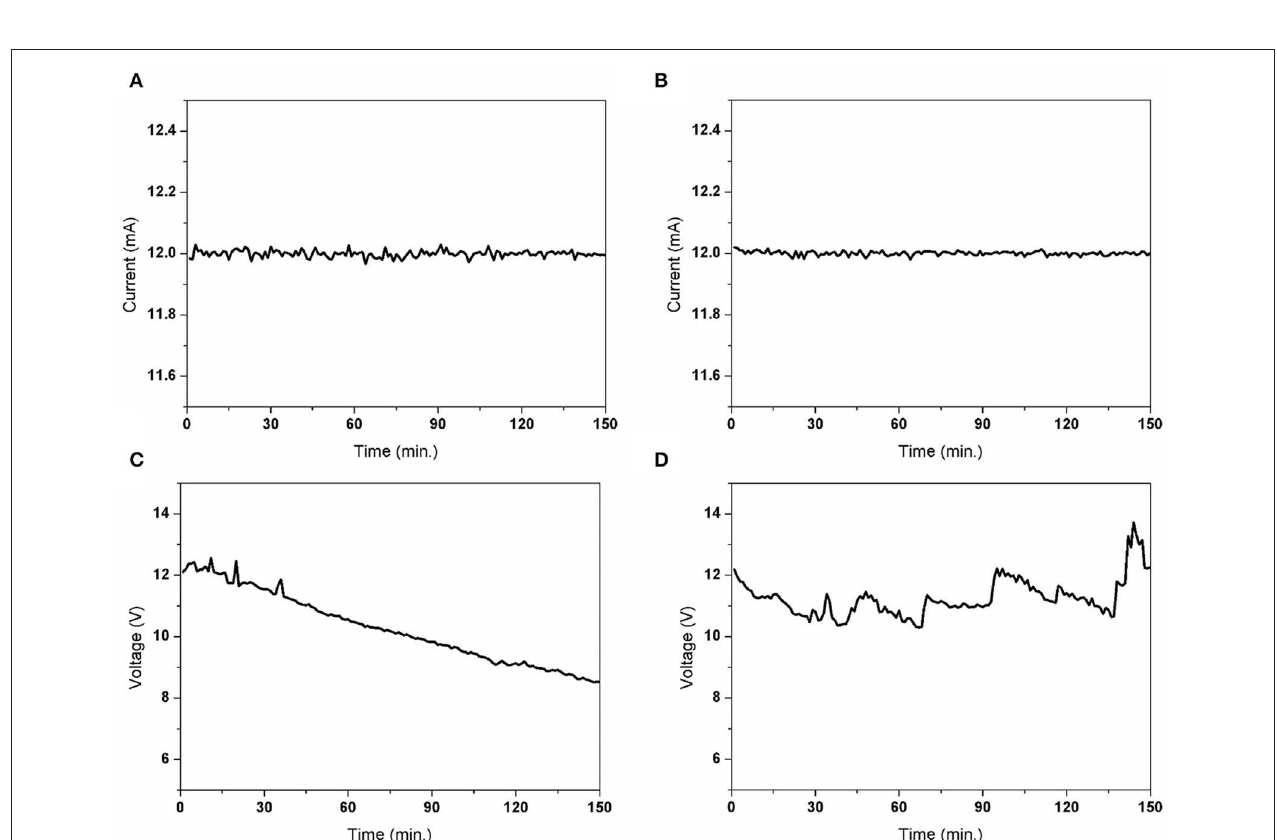
FIGURE 6 | Comparison of the electrical signal (current, voltage) with/without a gap change (distance between the substrate and working electrode) during the stacking of the Cu pillar for 150min. The small letters denote the following: (A) a nozzle fixed current variation; (B) gap controlled current variation; (C) nozzle fixed voltage variation; (D) gap-controlled voltage